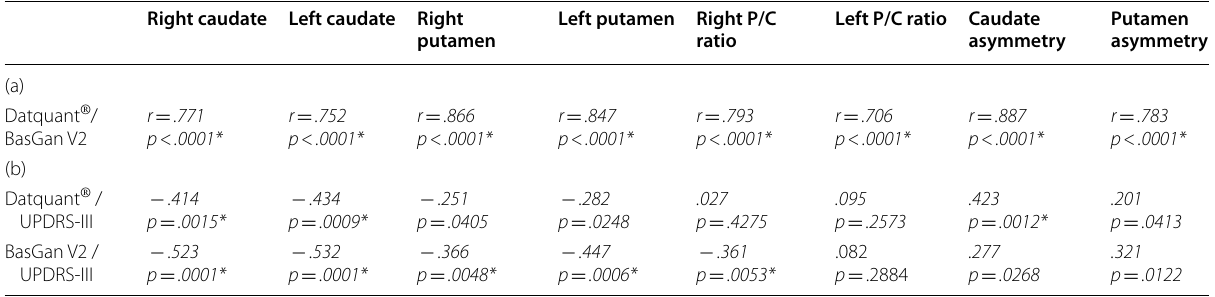
In the columns, the values of SBR, P/C ratio, and asymmetry are reported. Asymmetries are computed without taking into account the side of the more affected hemisphere. See the text for abbreviations. Italics characters show statistically significant correlation (one-tail Pearson’s r ), while * denotes those correlations surviving Bonferroni’s correction for multiple comparisons ( p .00625 as first level of statistical significance) =